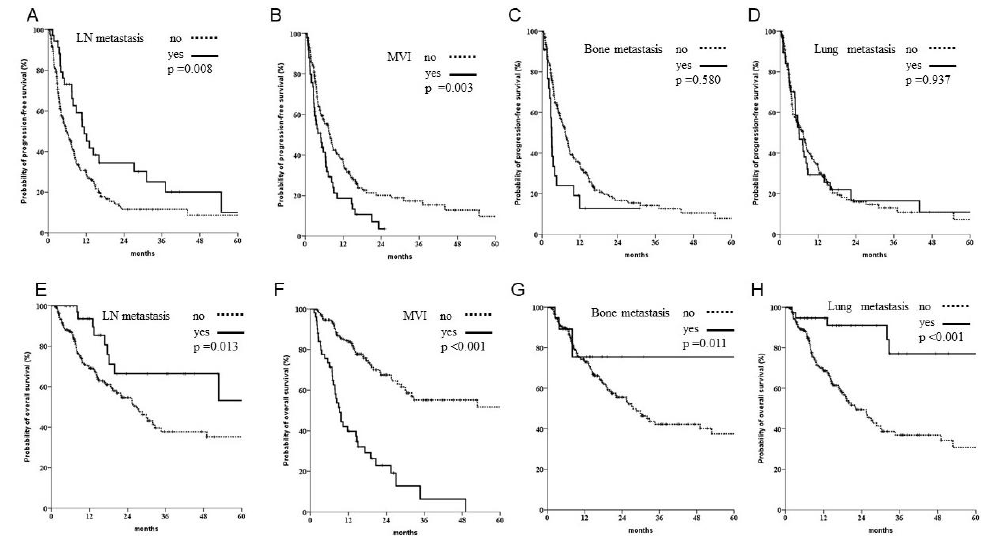
Figure 3. Subgroup analysis of progression and overall survival when patients with multiple targets were excluded. ( A – D ) Of 220 patients with single organ involvement, those with lymph node (LN) metastasis had better outcomes, whereas those with bone metastasis or macroscopic venous invasion (MVI) had worse outcomes. ( E – H ) Significant better OS was noted in patients with single organ involvement, including LNs, bones and lungs, but worse outcomes were observed in patients with MVI.